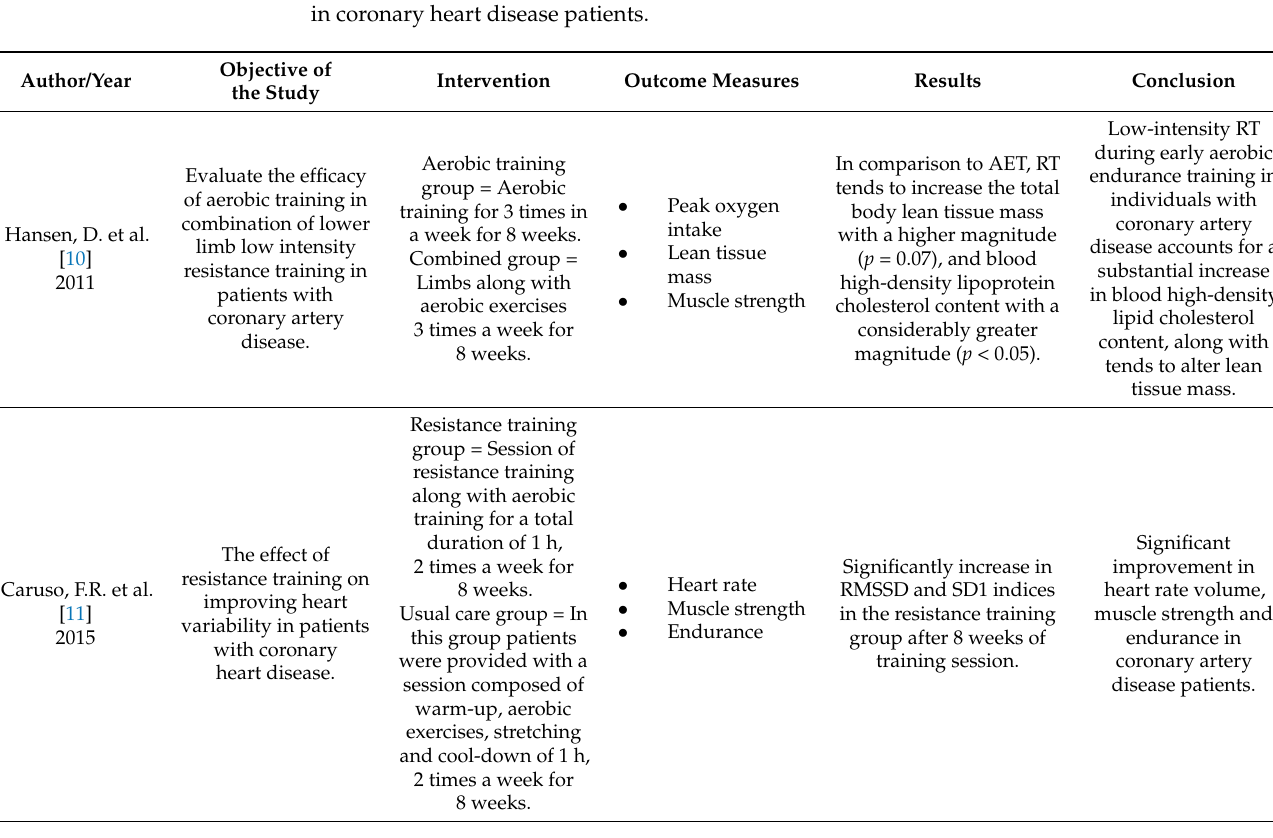
Table 2. Presentation of articles in line with objectives and main findings regarding exercise therapy in coronary heart disease